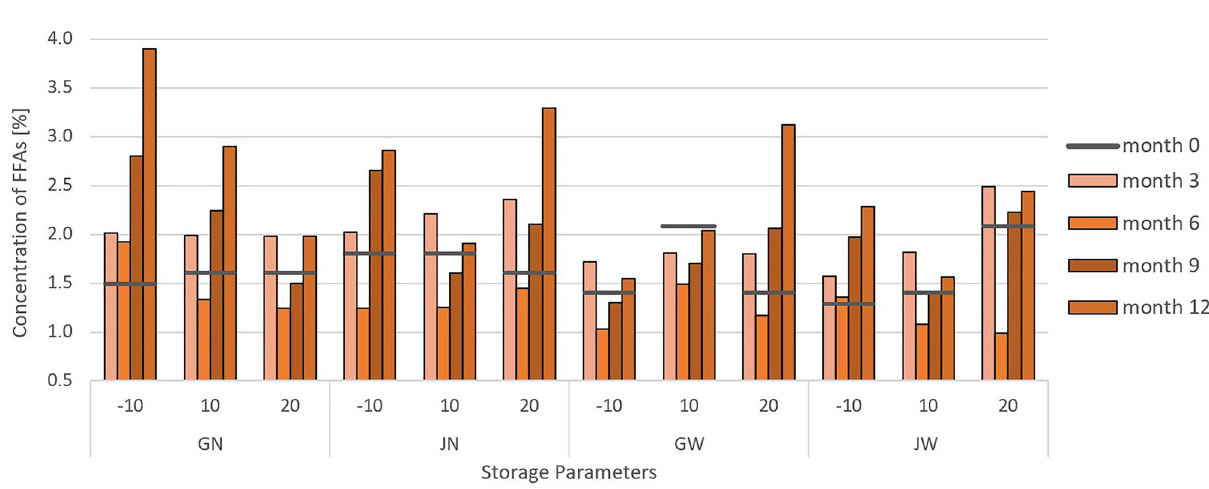
Figure 5. Diagram of average content of FFAs in dry mass analysed in tested green coffee samples on a 12-month basis (with results recorded every 3 months), after appropriate treatment, in